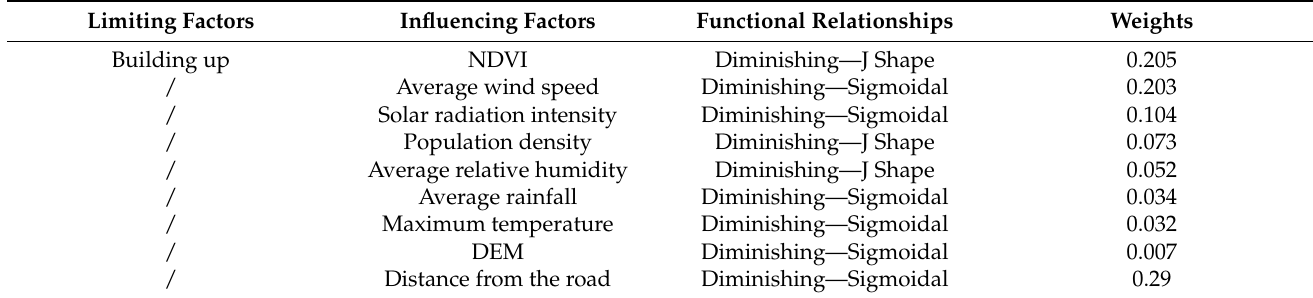
Figure 4. Pine state suitability atlas ( A , D ) are non-healthy pine forests in 2010 and 2020, respectively; ( B , E ) are health pine forests in 2010 and 2020, respectively; ( C , F ) are non-pine forest in 2010 and 2020, respectively. Table 2. The elements and weights table of PWD suitability atlas.